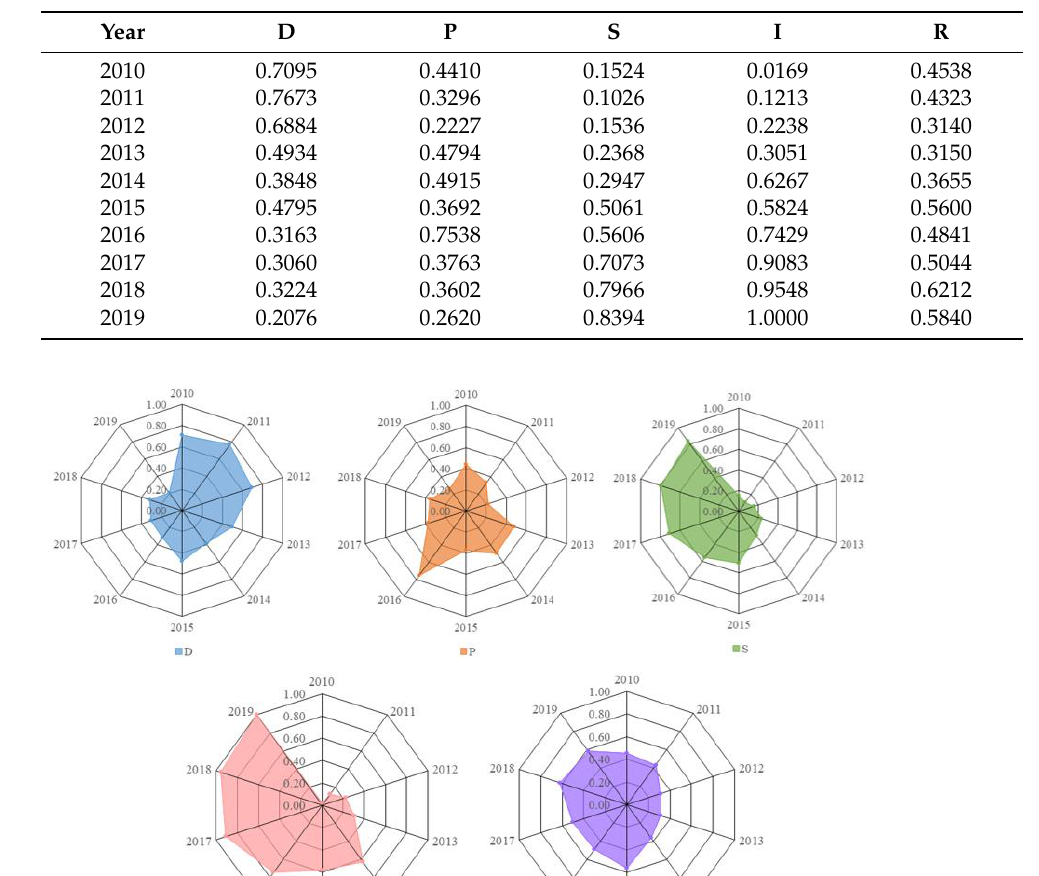
Table 5. Evaluation values of water resource carrying capacity subsystems of Zhengzhou from 2010 to 2019.